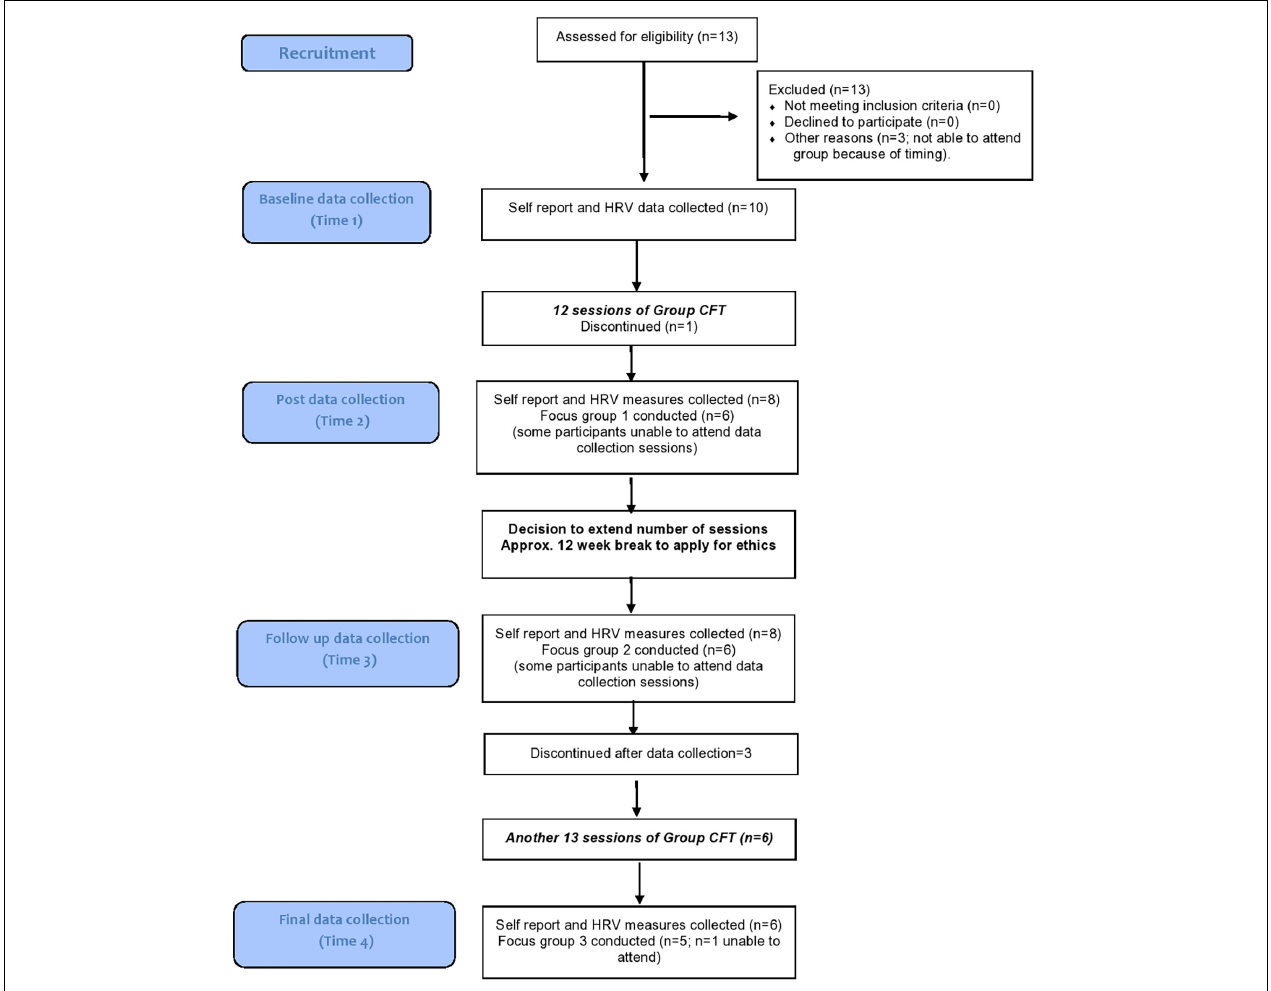
FIGURE 4 | Participant